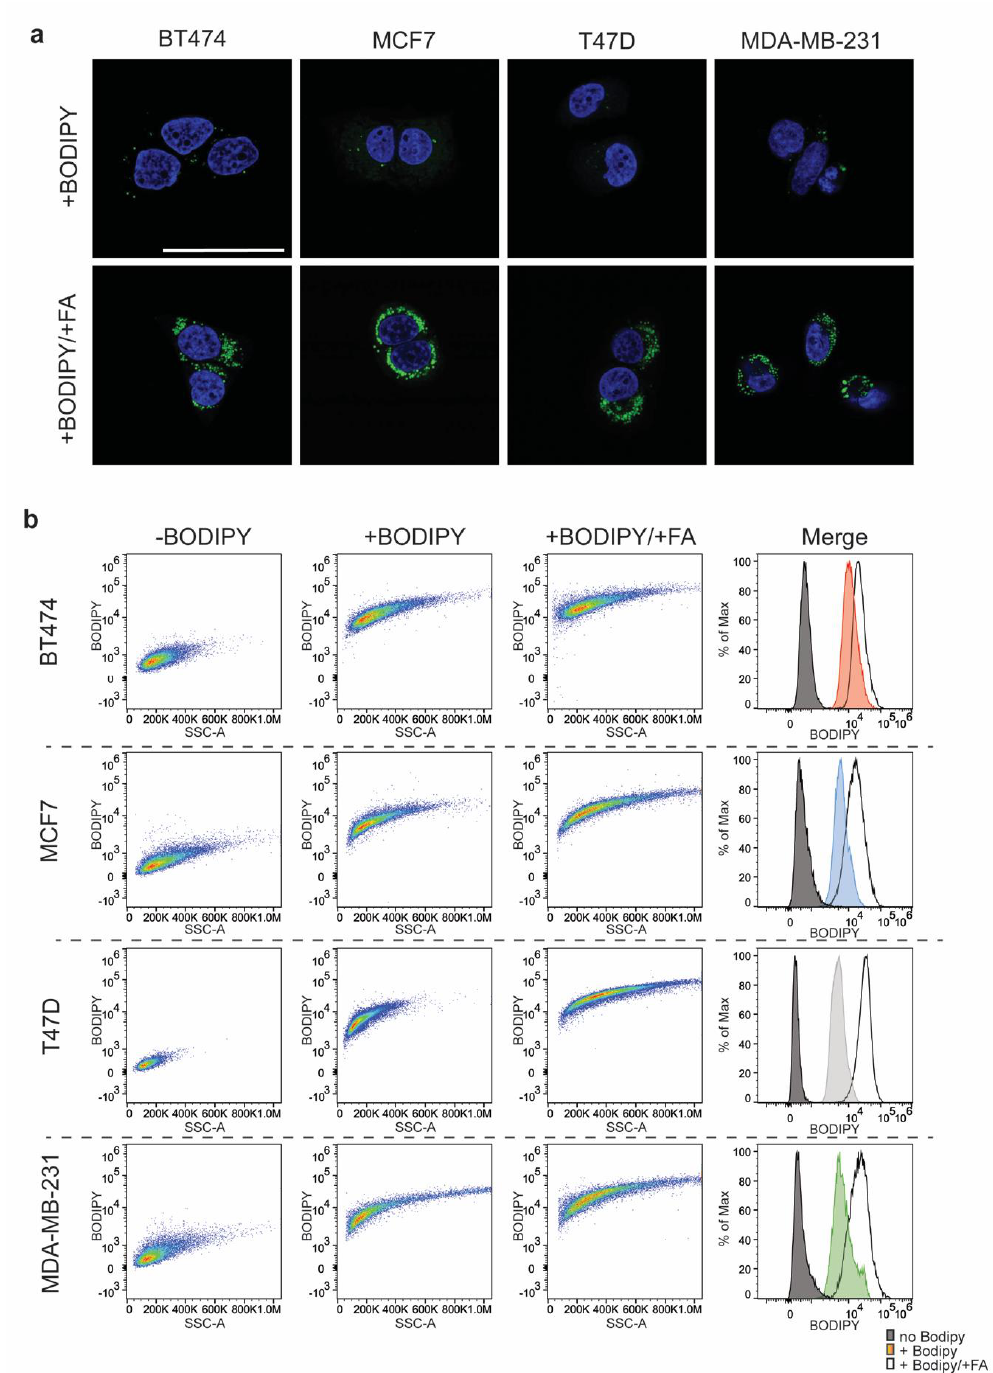
Figure 2 . BODIPY TM based FACS protocol distinguishes lipid droplet enriched cells. ( a ) Confocal imaging of BODIPY TM 500,510 loaded cells. Upper panels are representative images from each of the four cell lines following a 12 h incubation with BODIPY TM , lower panel representative image of cells incubated with palmitic acid, oleic acid and BODIPY TM . The scale bar represents 50 μ m. ( b ) Representative plots of BODIPY TM signal in cells, – BODIPY TM , + BODIPY TM, and fatty acid loaded cells + BODIPY TM . The corresponding histograms represent the FITC (BODIPY TM ) signal for each condition.